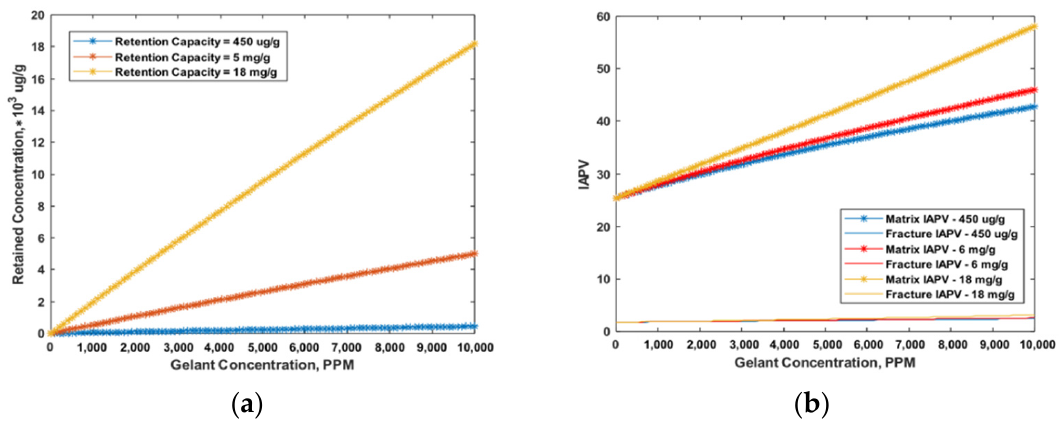
Figure 6. Effect of gelant retention capacity on IAPV. ( a ) Input cases setup; ( b ) Results of IAPV in percentage.